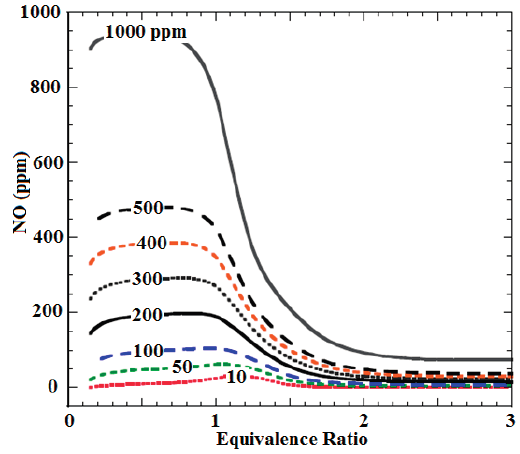
Figure 11. NO reburning results for various levels of NO addition to the methane/air reactant stream against a range of equivalence ratios